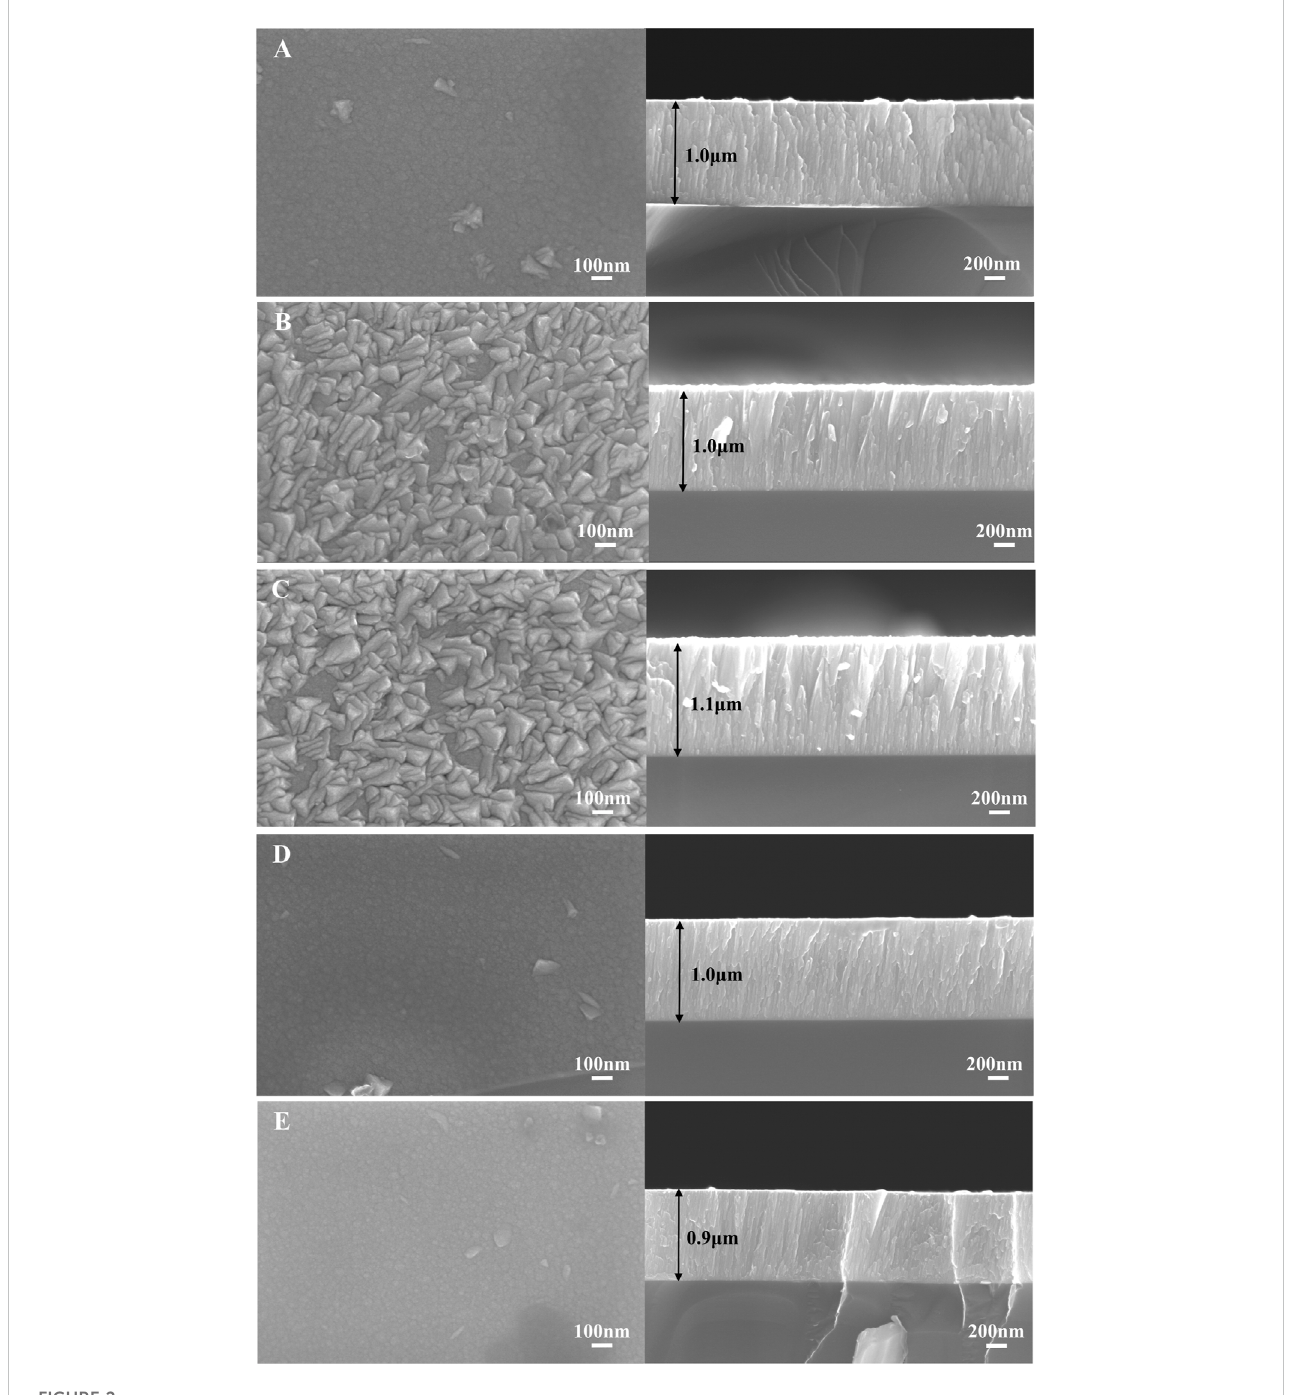
FIGURE 2 SEM images of the surface and cross-section of the ZrNbTiMo RHEA fi lms deposited at different sputtering power: (A) 90 W, (B) 120 W (C) 150 W, (D) 180 W, and (E) 210 W.